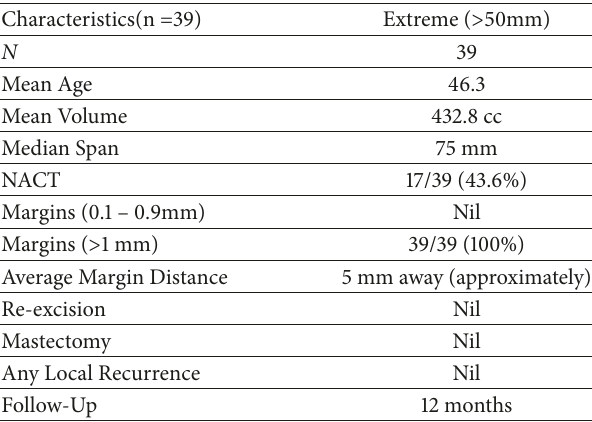
Table 2: Salient features of EO